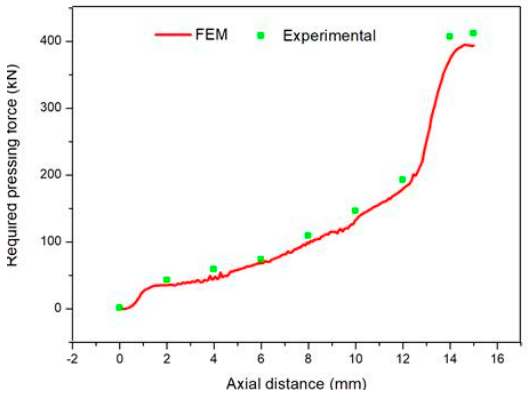
Figure 5. Finite Element Method validation graph.